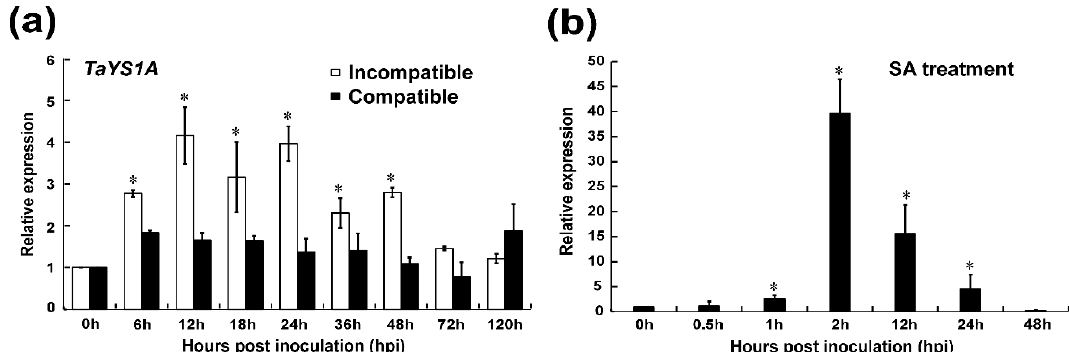
Figure 1. Analysis of TaYS1A expression in Puccinia striiformis f. sp. tritici (Pst ) inoculated and